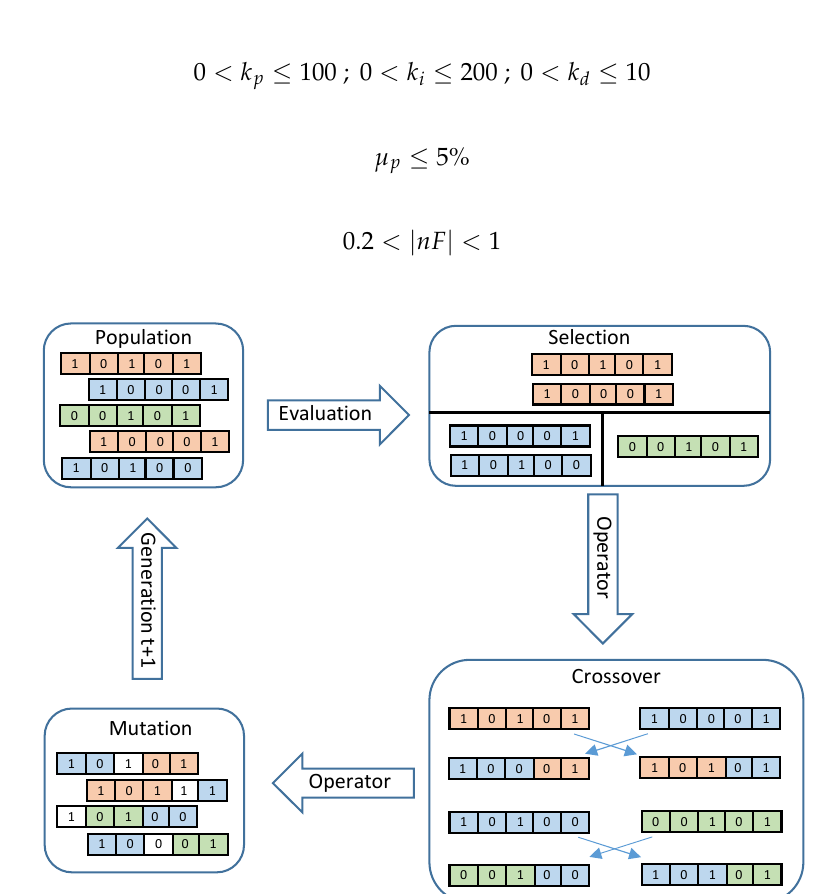
Figure 3. Flow chart for Genetic Algoritms (GA)